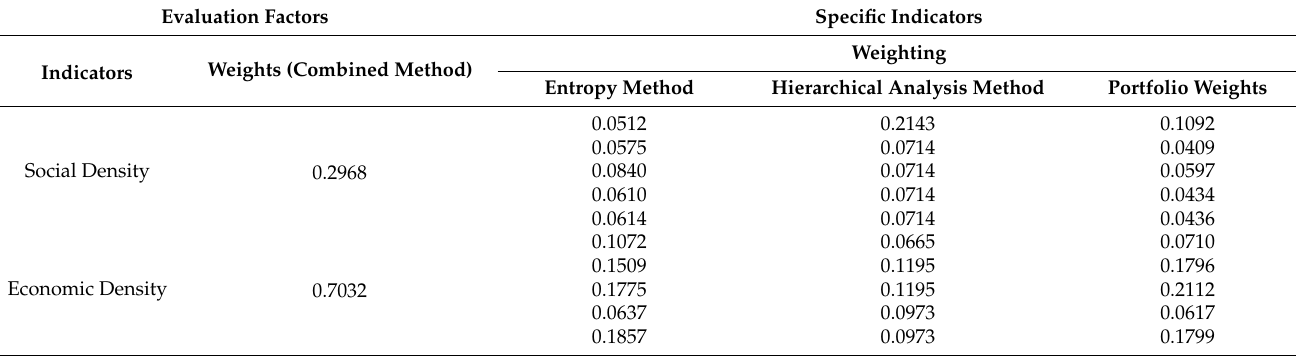
Table 5. Weight of density resilience index determined by different